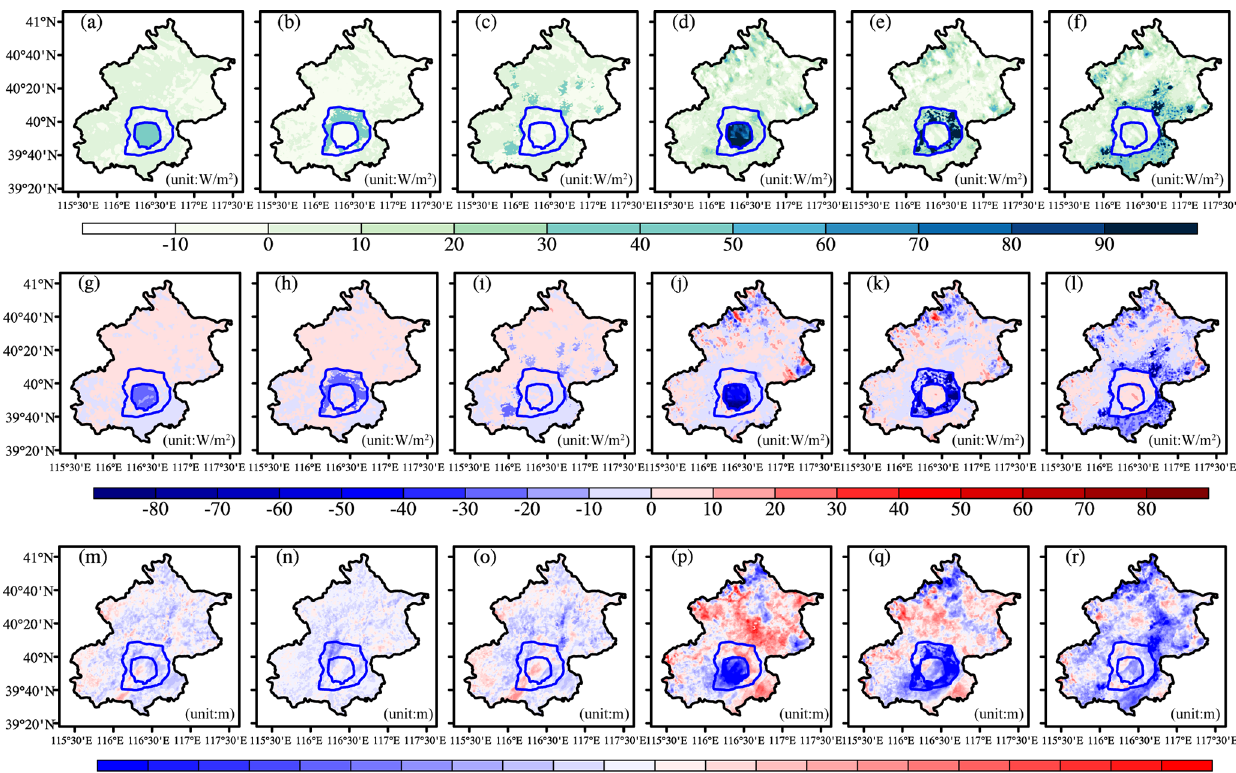
Figure 11. Changes in the latent heat flux, sensible heat flux, and boundary layer height due to road sprinkling and urban irrigation. (a) Changes in latent heat flux (LH) due to road sprinkling in the city center. (b) Changes in LH due to road sprinkling in the suburbs. (c) Changes in LH due to road sprinkling in rural areas. (d) Changes in LH due to urban irrigation in the city center. (e) Changes in the LH due to urban irrigation in suburbs. (f) Changes in LH due to urban irrigation in rural areas. (g–l) Changes in sensible heat flux in a similar manner to panels (a–f) . (m–r) Changes in the boundary layer height in a similar manner to panels (a–f)